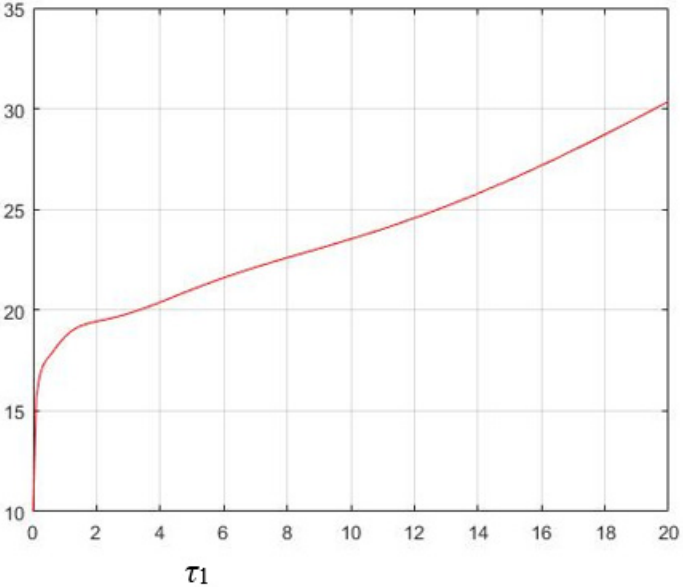
τ * 0 τ = = 0. 1 1 , and .